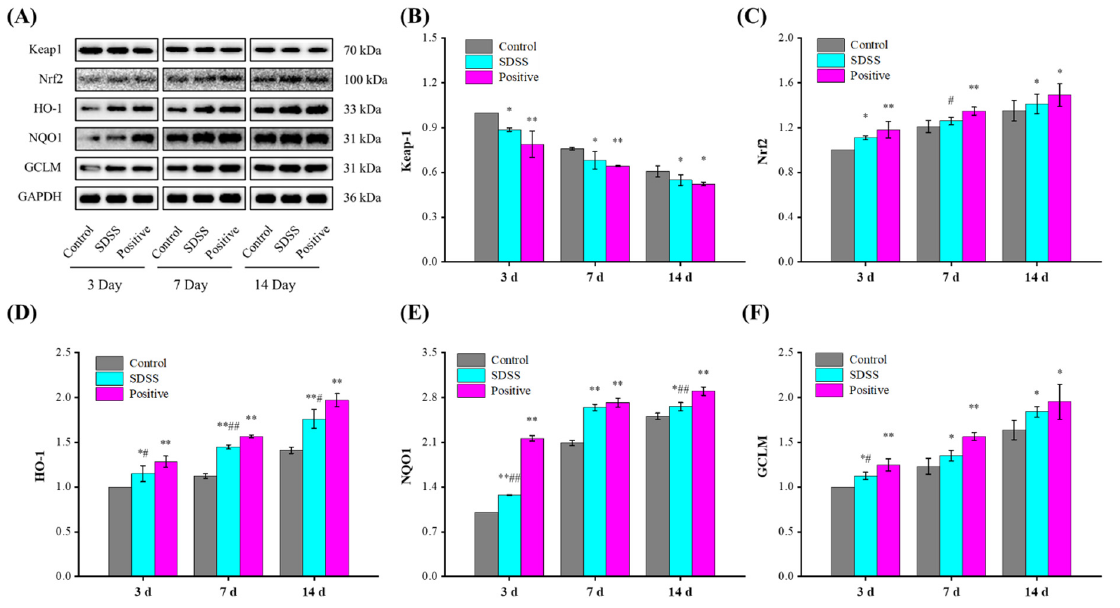
Figure 6. Effect of SDSS on the protein levels of the Nrf2/HO-1 pathway ( n = 5). ( A ) Western blot; the protein expression levels of Keap1 ( B ), Nrf2 ( C ), HO-1 ( D ), NQO1 ( E ), and GCLM ( F ) levels. * p < 0.05, ** p < 0.01 when compared to the control group. # p < 0.05, ## p < 0.01 when compared to the positive group.